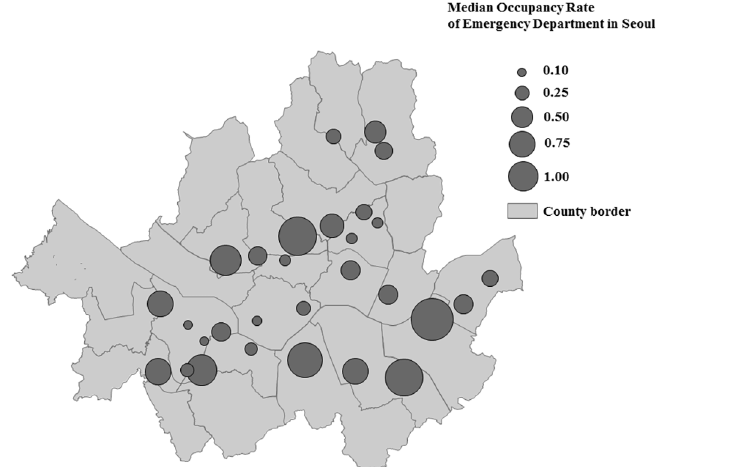
Fig 1. Median occupancy rate of emergency departments in Seoul. doi:10.1371/journal.pone.0130758.g001 Table 2 shows the results of the linear regression analysis and multi-level regression model with random effects for EDs. An increase in 1% of occupancy rate was associated with 0.02 minute (95% CI: 0.01 to 0.03) decrease in turnaround time. When limited to patients treated at EDs with an occupancy rate of 100% or greater, we observed a 0.03 minute (95% CI: 0.01 to 0.05) decrease in turnaround time per 1% increase in occupancy rate (Table 3). A sensitivity analysis was performed. Emergency departments with average occupancy rate below 0.5 showed positive association between occupancy rate and turnaround time without statistical significance. (Coef. = 0.03 (95% CI: -0.00 to 0.06, p = 0.08) Emergency departments with average occupancy rate between 0.5 to 1.0 showed positive association between occupancy rate and turnaround time without statistical significance. (Coef. = 0.03 (95% CI: -0.01 to 0.07, p = 0.10) Emergency departments with average occupancy rate above 1.0 showed positive asso- ciation between occupancy rate and turnaround time without statistical significance. (Coef. = -0.05 (95% CI: -0.08 to -0.02, p < 0.001)